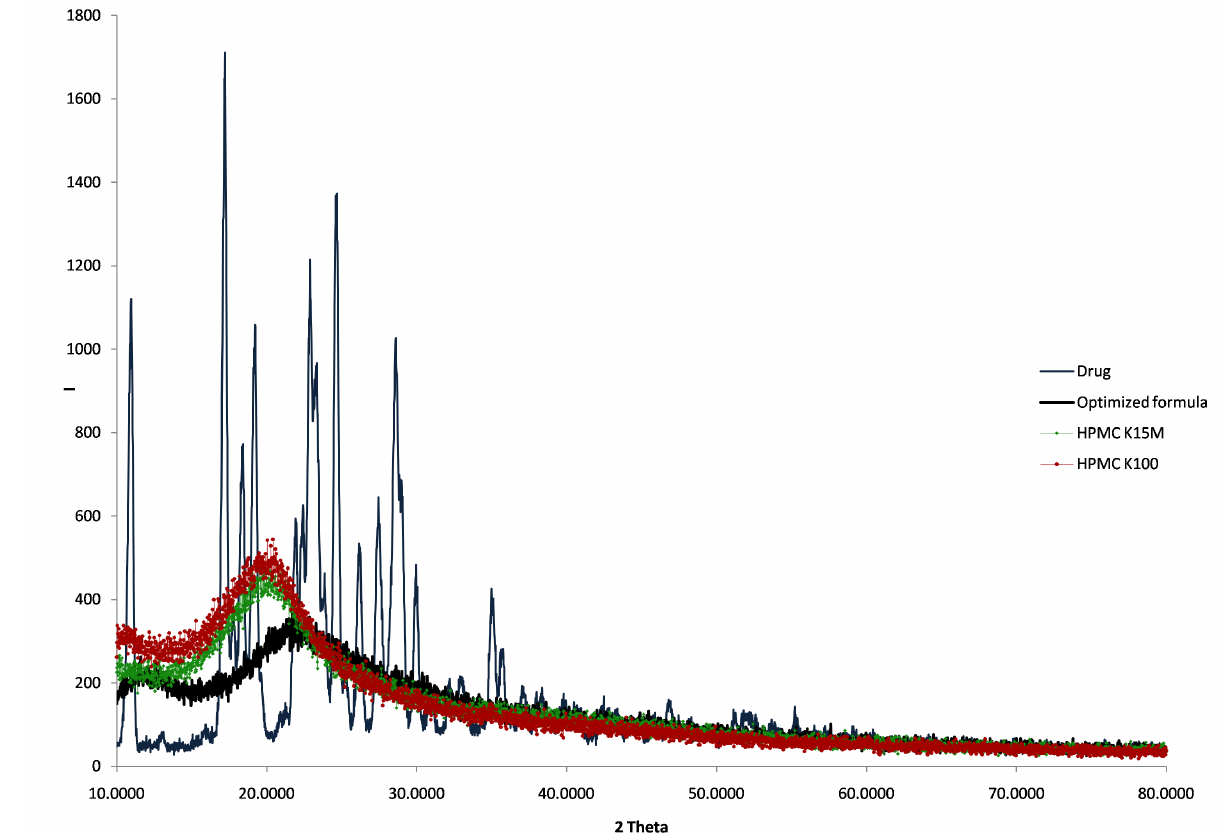
FIGURE 10 - Overlay XRD diffractogram for pure drug, optimized formula, HPMC K15M and HPMC